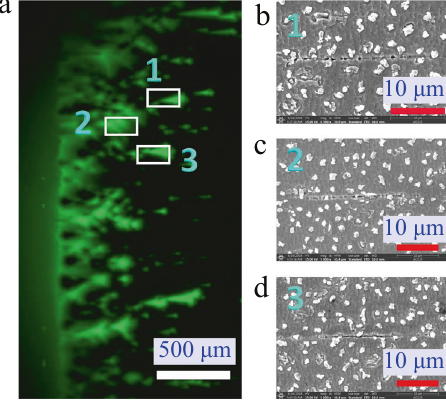
Fig. 7 MO image and SEM images at the local microlevel. a The MO image of a 0.73% strained sample. b – d Three microlevel local SEM images from ( a ), where their damages were observed in these fl ux penetrated